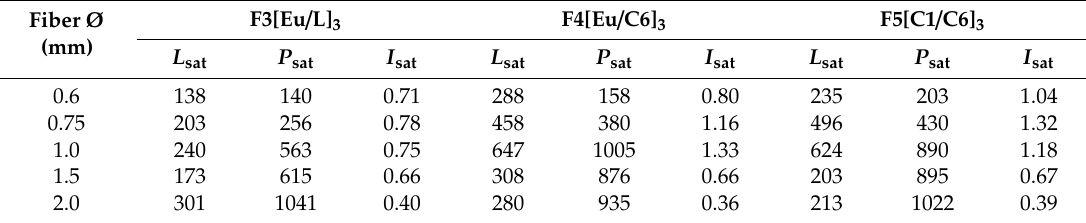
Figure 9. Evolution of the output power as a function of the illuminated fiber length for 1 mm diameter samples. Symbols: experimental points; solid lines: fitted curves.